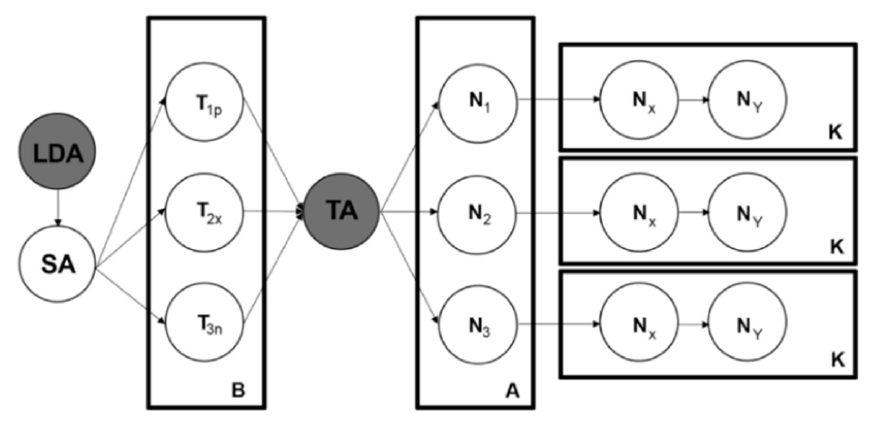
Figure 4. Textual analysis process. Source: Adapted from Saura and Bennett [52].